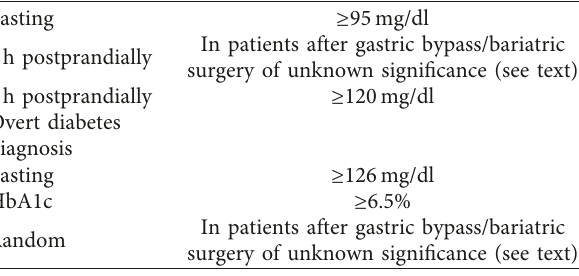
Table 2: Suggestions for diagnosis of gestational diabetes and overt diabetes in early pregnancy ( < 20 weeks of gestation) following metabolic surgery using capillary blood glucose monitoring (adapted from [40,